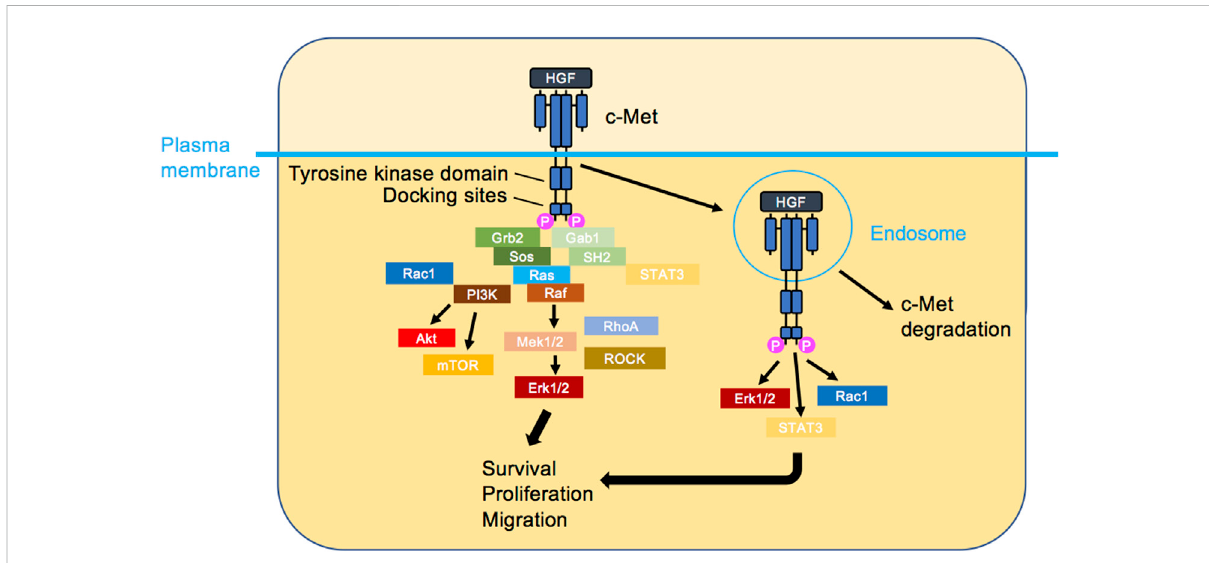
FIGURE 2 c-Met signalling. HGF triggers c-Met dimerisation, activation and the initiation of several signalling cascades. The classical view is that c-Met signallingoccursattheplasmamembrane(left).Recently,ithasbeenshownthatHGF-boundc-Metinternalisesrapidlyandtransmitssignallingfrom endosomes (right), leading to the activation of signal transducer and activator of transcription 3 (STAT3), ERK1/2 and PI3K/AKT. Ultimately, cellular responses such as survival, proliferation and migration are